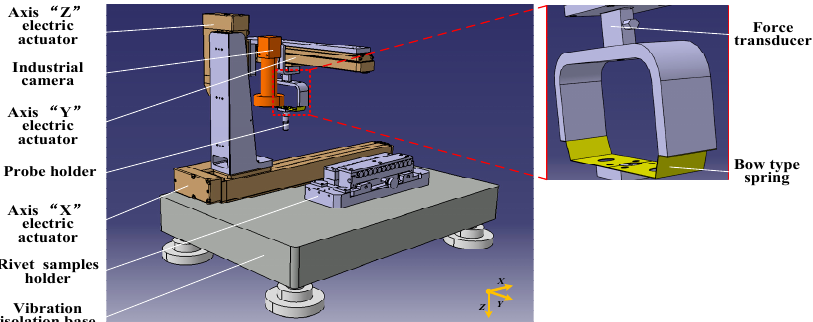
Figure 1. 3D model of the mechanical structure (without housing).